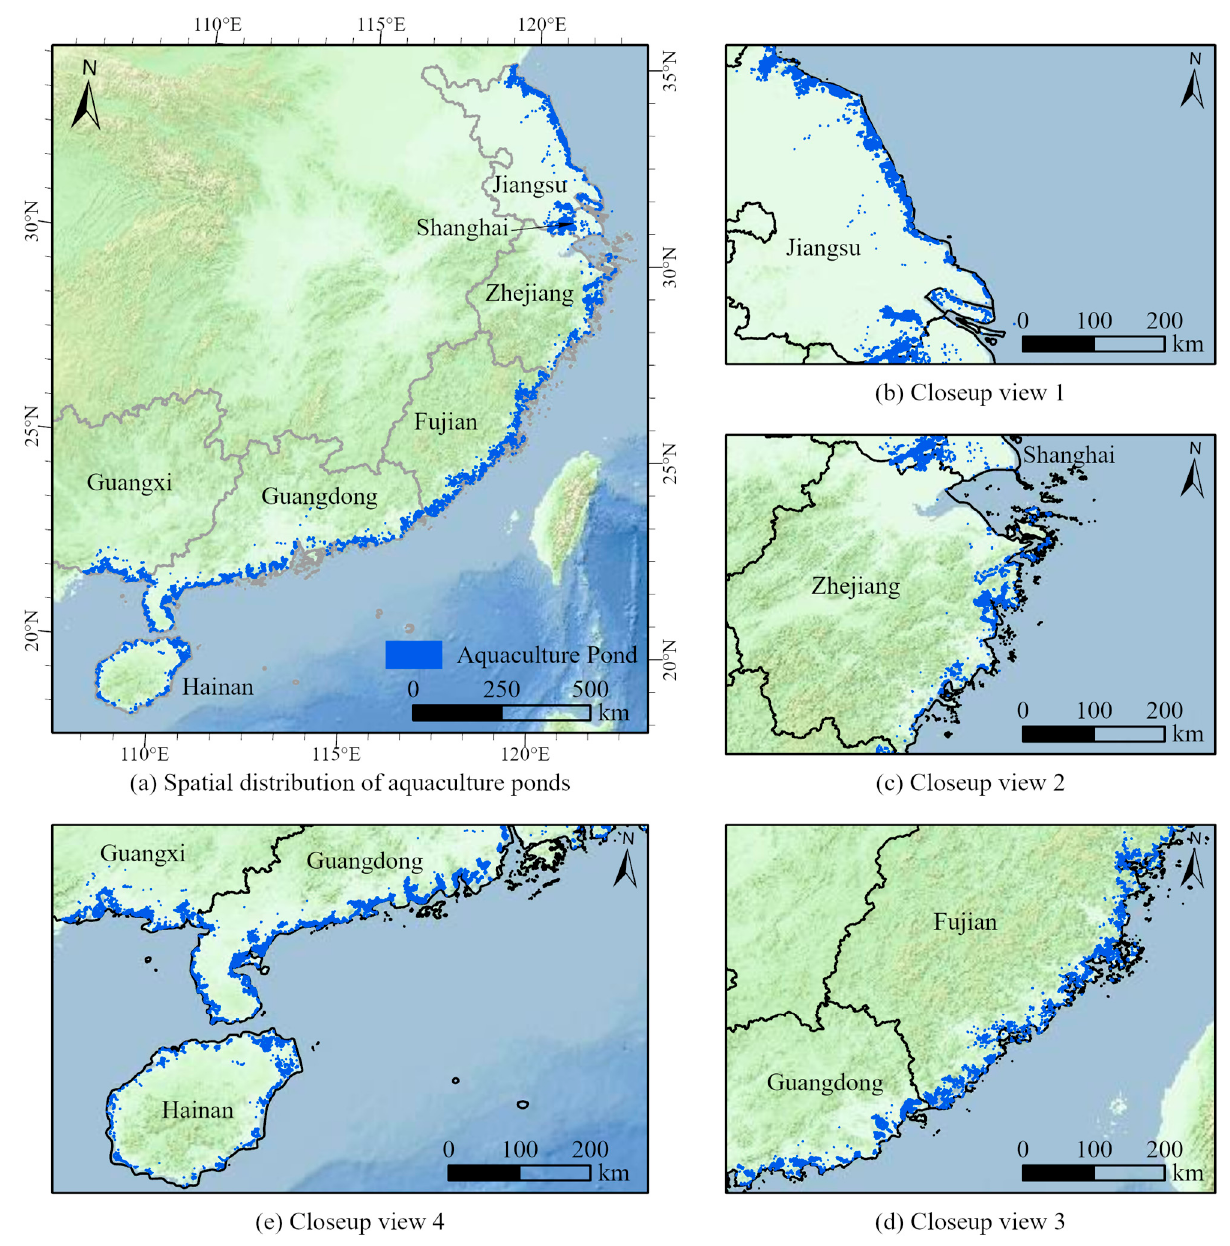
Figure 11. Spatial distribution of aquaculture ponds in coastal waters of the southeast region.